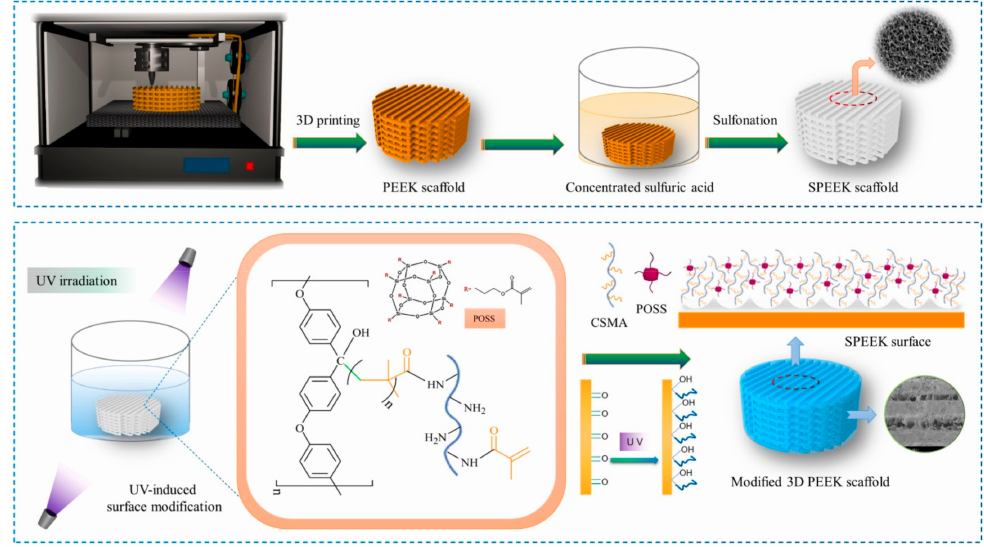
Figure 5. Illustration of the fabrication and surface modification processes of 3D-printed PEEK scaffold [Reprinted with permission from Ref.